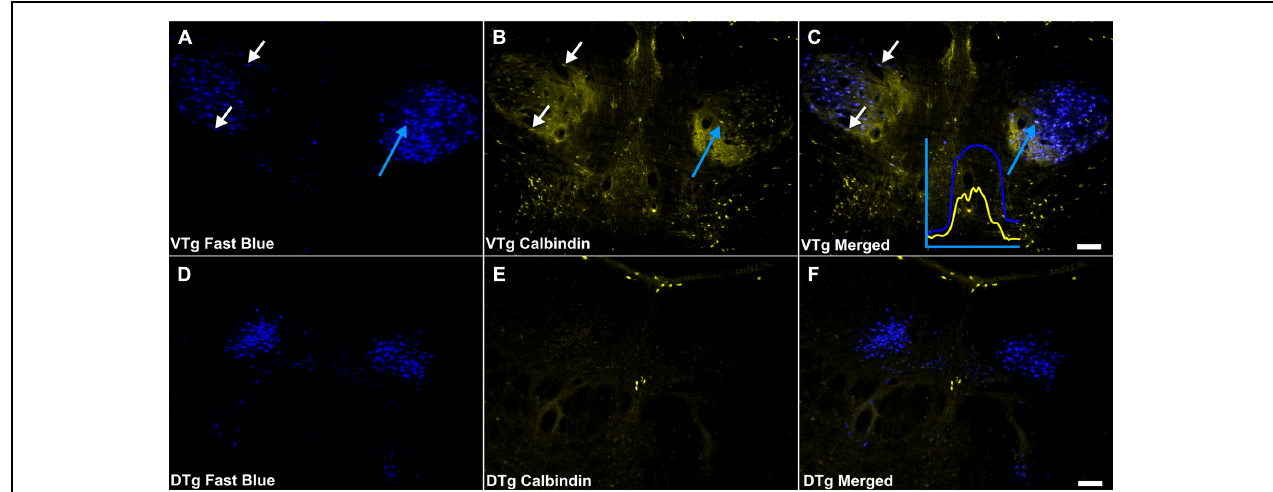
FIGURE 7 | Calbindin/Gudden’s tegmental nuclei: (A,D) Fluorescent photomicrographs showing retrograde Fast Blue cell body label in the VTg and dorsal tegmental nuclei of Gudden (DTg), respectively. (B , E) show fluorescent CB immunoreactivity in respective sections while (C , F) show retrograde Fast Blue label and CB immunoreactivity superimposed. White arrows in (A–C) identify examples of individual retrogradely Fast Blue labeled cells (A) that co-localized CB (B) and the resulting co-localization of signal (C) . Further confirmation of colocalization